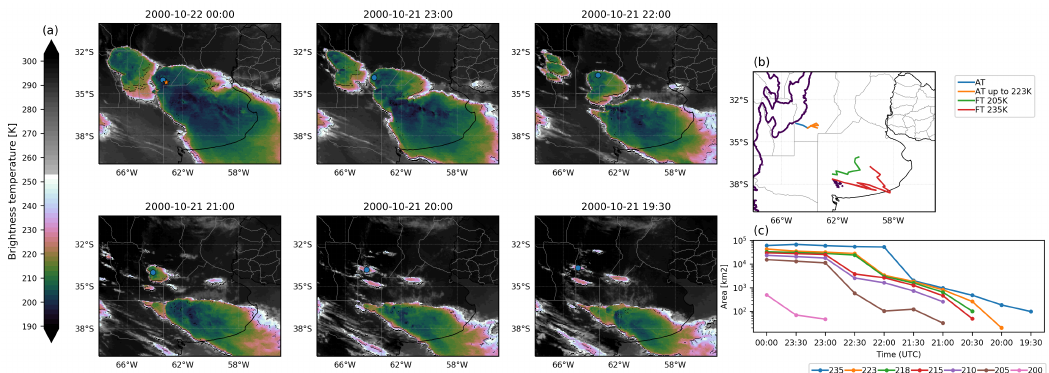
Figure 6. Same as Figure 4, but for 22 October